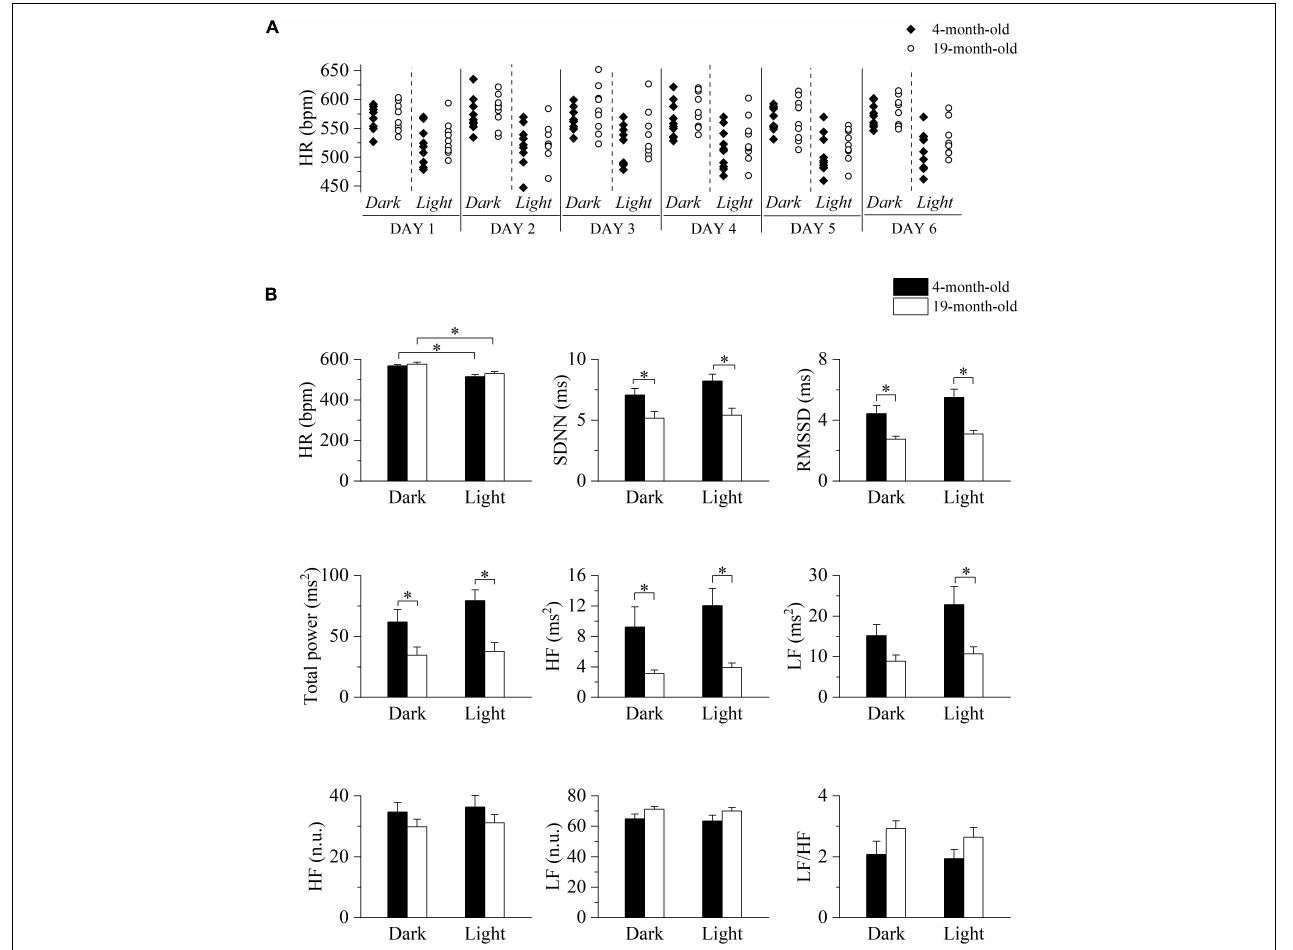
FIGURE 1 | Long-term evaluation of HR and HRV in 4- and 19-month-old freely moving mice. (A) Time course of heart rates (HR) recorded during the 12-h light and 12-h dark phases of six consecutive days in 4-month-old ( n = 10, filled diamonds) and 19-month-old ( n = 9, empty circles) freely moving mice. (B) Mean heart rate and heart rate variability parameters evaluated from ECG traces recorded from 4-month-old and 19-month-old mice during the daily cycle (dark and light phases). Data are reported as mean ± SEM. SDNN, standard deviation of beat-to-beat intervals; RMSSD, root mean square of successive beat-to-beat interval differences; LF, low frequency; HF, high frequency; LF (n.u.), low frequency in normalized units; HF (n.u.), high frequency in normalized units. ∗ p < 0.05, two-way ANOVA for repeated measures followed by Fisher’s LSD post hoc